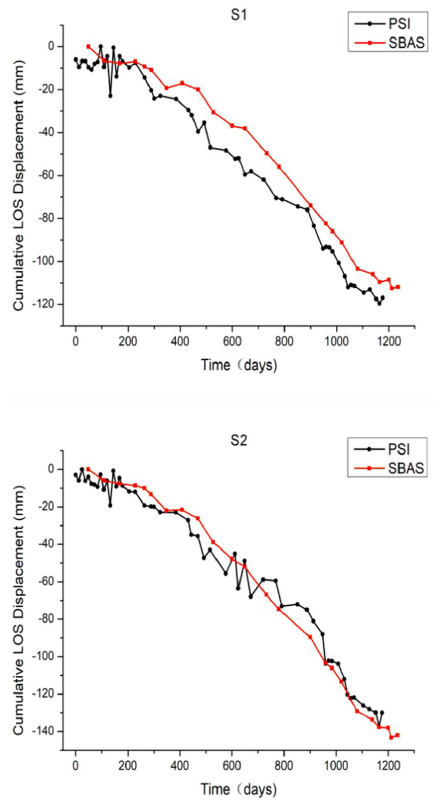
Figure 12. The representative sites in the Residential Area Zone.